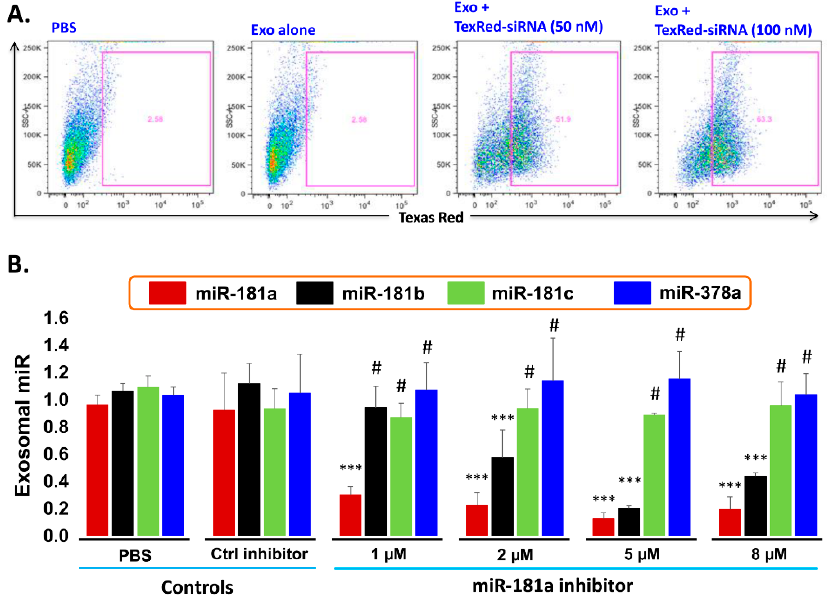
Figure 6. Cellular uptake e ffi ciency of TexRed-siRNA and dose optimization of miR-181a-5p inhibitor. ( A ) TaxRed-siRNA transfection e ffi ciency into Exo-JM1 and cellular uptake of exosome was